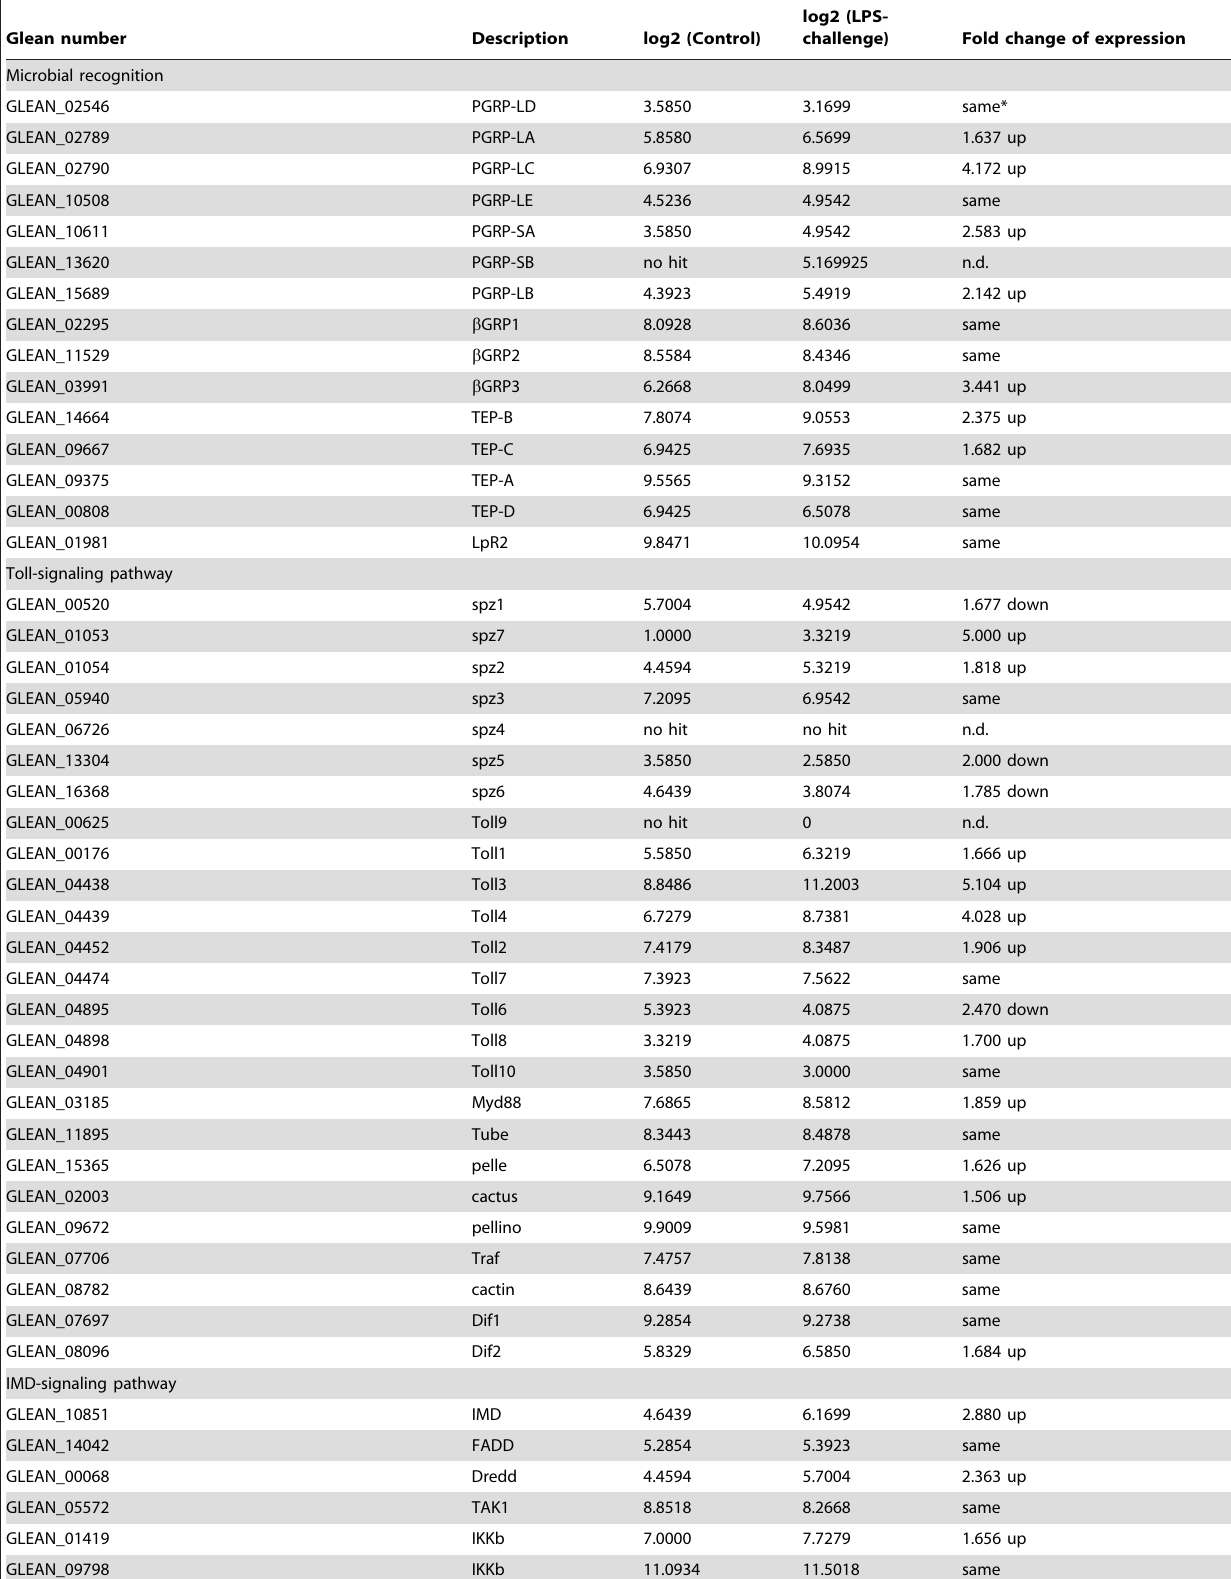
Table 4. Expression levels of immune-related genes in adult beetles.